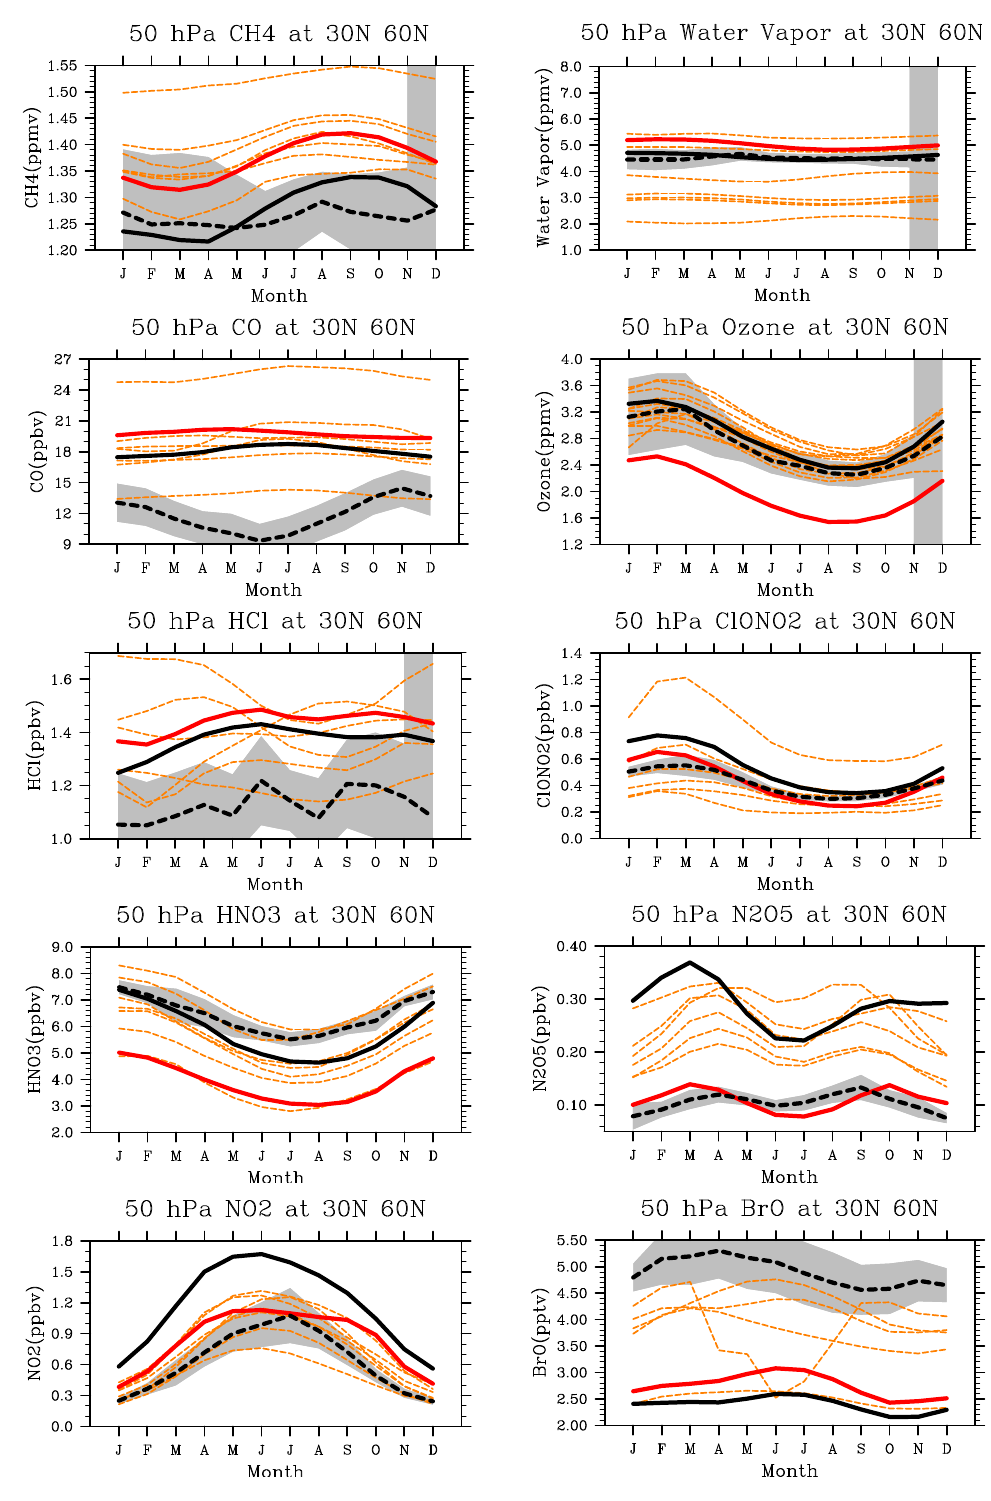
Fig. 12. Mean annual cycle at 50hPa over 30 ◦ N–60 ◦ N for CH 4 (ppmv) and H 2 O (ppmv) (first row), CO (ppbv) and O 3 (ppmv) (second row), HCl (ppbv) and ClONO 2 (ppbv) (third row), HNO 3 (ppbv) and N 2 O 5 (ppbv) (fourth row), and NO 2 (ppbv) and BrO (pptv) (last row). Observations (dashed black line, ± 1 σ , see text), CNRM-ACM (red line), CNRM-CCM (black line) and CCMVal-2 REF-B1 models (dashed orange lines).